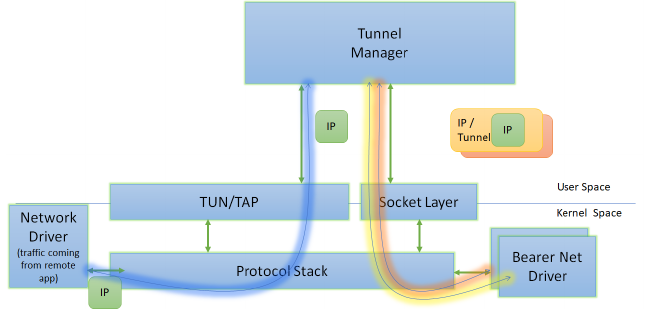
Figure 10. Tunnel Manager packet